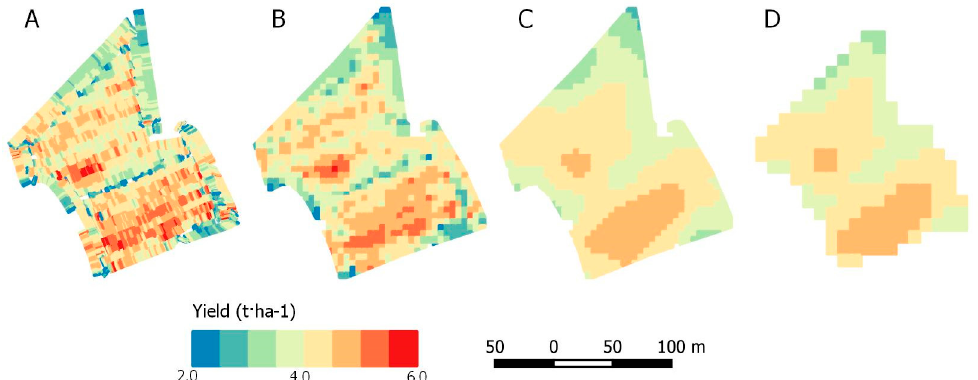
Figure 1. Example of the harvester data curation of a Bomba rice field within the training samples being ( A ) the original harvester machine data, ( B ) the 5 m aggregated data, ( C ) the 5 m aggregated data after applying the grid moving average filter and ( D ) picture C aggregated to 10 m.